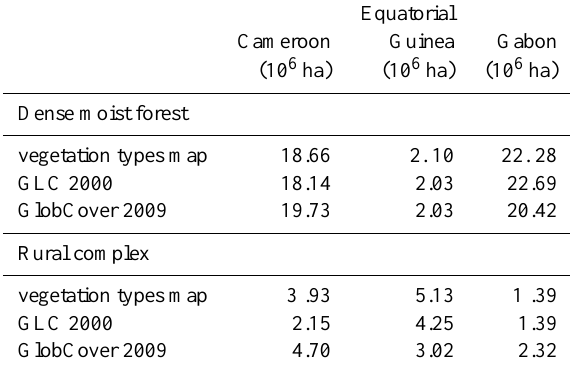
Table 11. Dense moist forest and rural complex areas from the veg- etation types map, GLC 2000 and GlobCover 2009 in countries near the Atlantic